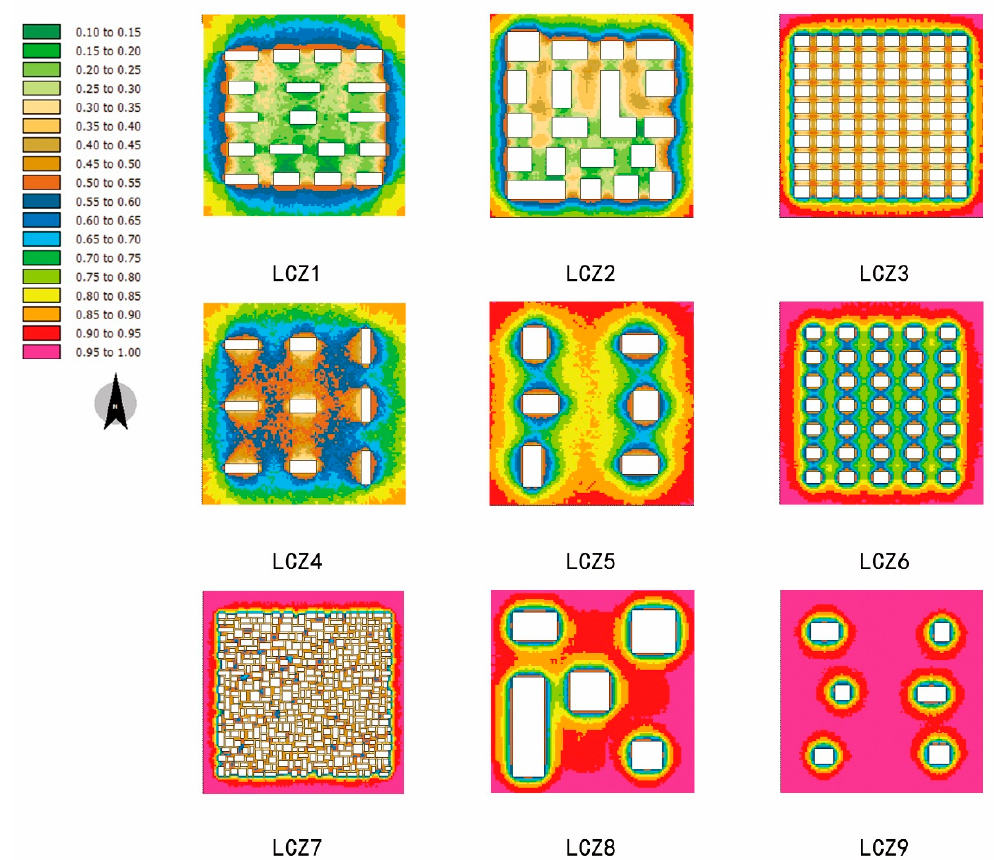
Figure 3. Spatial distribution of the sky view factor (SVF) for all the nine models.